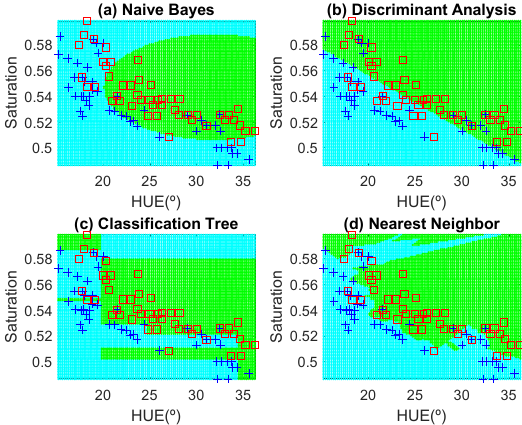
Figure 17. Decision boundaries and scatter plot (class 1 squares, class 2, crosses) for the red apple. ( a ) Naive Bayes, ( b ) linear discriminant analysis, ( c ) classification tree and ( d ) Nearest Neighbor (k=5).